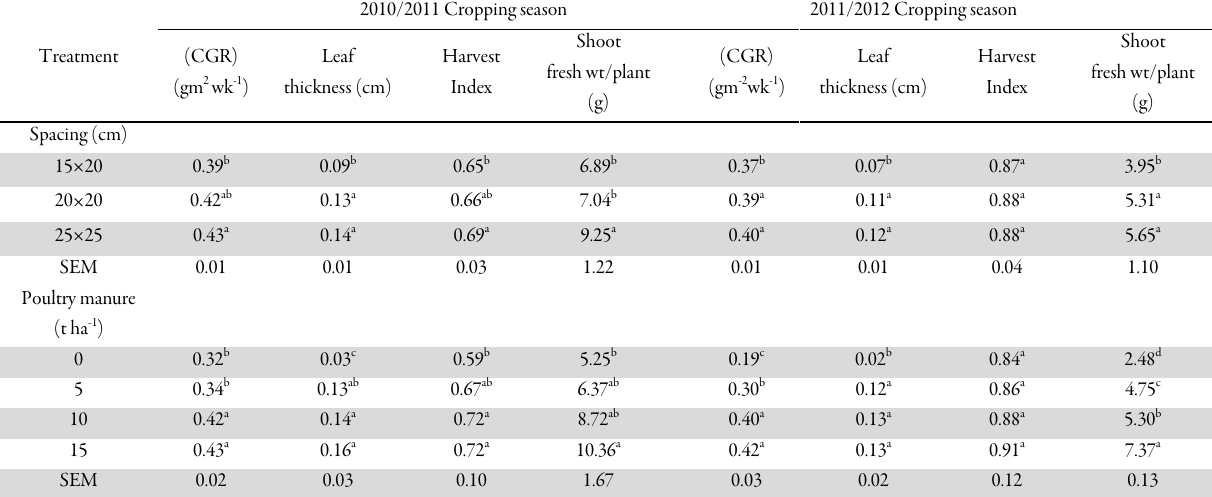
Table 2. Effect of spacing and poultry manure on crop growth rate (CGR) gm -2 wk -1 , leaf thickness (cm), harvest index and shoot fresh wt/plant (g) of onion 2010/2011 and 2011/2012 dry cropping seasons